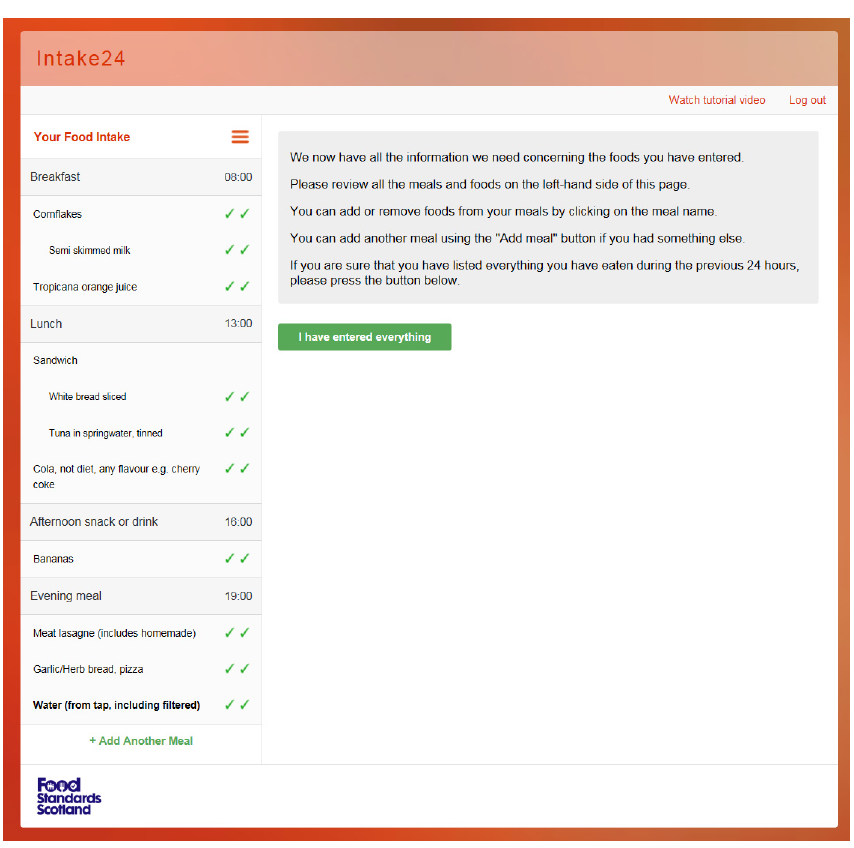
Figure 6 . Final review stage in INTAKE24.